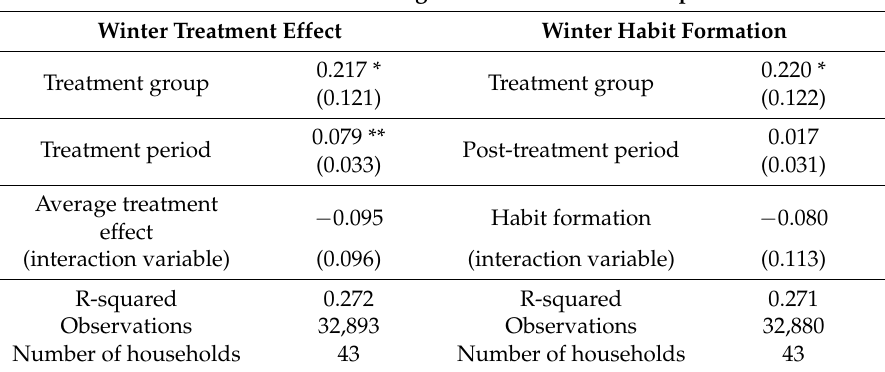
Table 6. Winter experiment’s regression results.